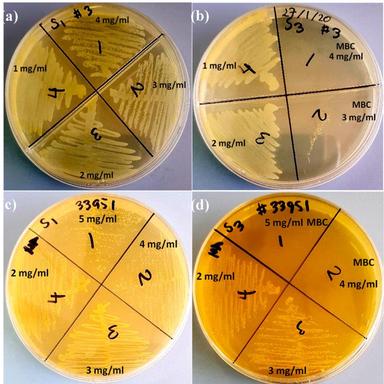
MHA plates showing MBC (mg/ml) value for MDR-PA strains treated with different concentrations of pure g-C3N4 (a) MDR-PA strains treated with different concentrations of 10%-3C–SiC@g-C3N4 (b), MRSA strains treated with different concentrations of pure g-C3N4 (c) MRSA strains treated with different concentrations of 10%-3C–SiC@g-C3N4 (d) after 24 h of incubation at 37 ◦C.